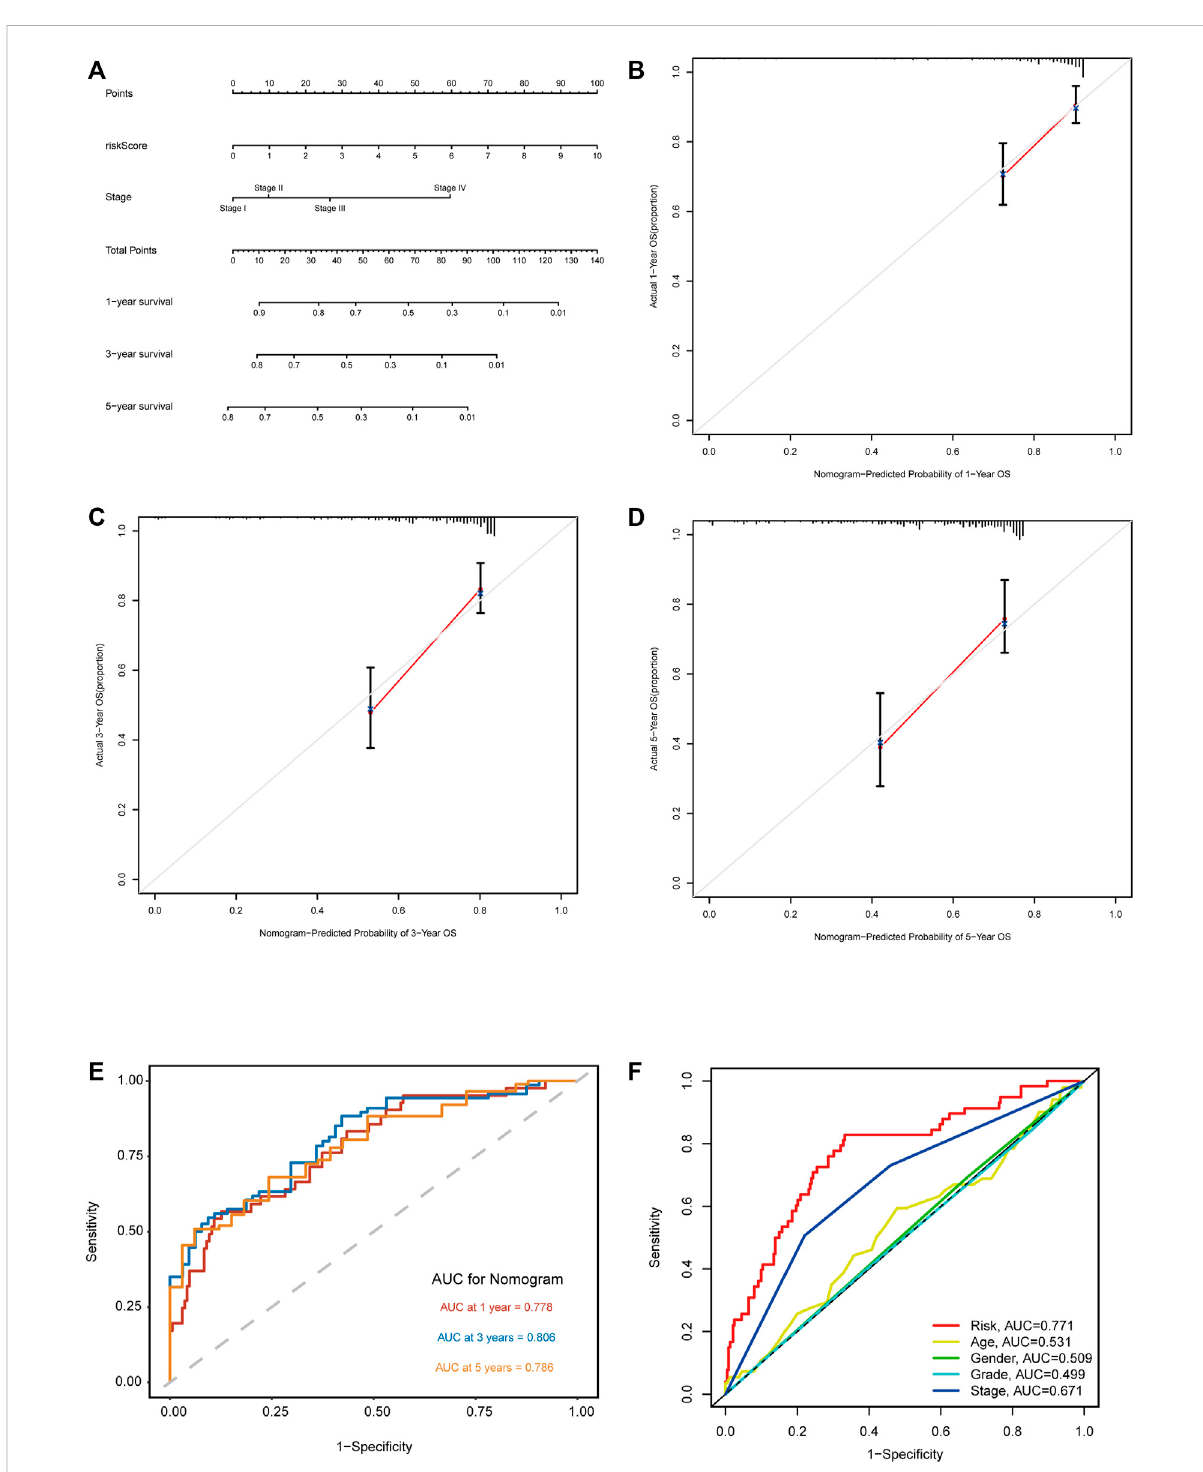
FIGURE 6 Construction and validation of the nomogram based on m5C-related lncRNA risk model. (A) Nomogram with risk score and TNM stage for predicting 1-, 3-, and 5-year survivalfor HCCpatients. (B – D) The calibrationcurves showing theconsistency ofnomogram-predictedand actual 1-, 3-, and 5-year OS. (E) ROC analysis evaluating the predictability of the nomogram for 1, 3, and 5 years OS. (F) A comparison of AUC of risk score and clinical factors at 1-year showed the optimal prognostic value of the risk